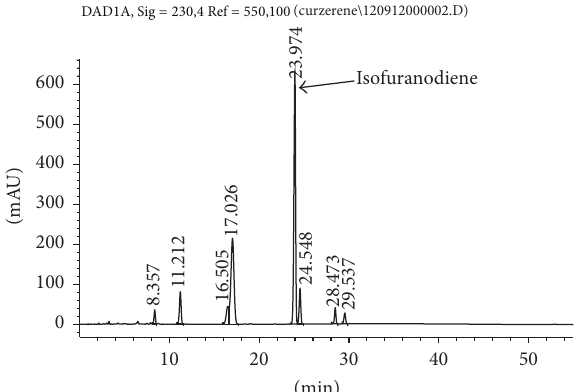
Figure 2: HPLC chromatogram of the essential oil from flowers of Smyrnium olusatrum . Isofuranodiene with a retention time of 23.974 ministhemainpeak(48%).Thechromatographicconditions are as follows: column: Kinetex PFP 100A ( 100 × 4.6 mm i.d., 2.6 𝜇 m) from Phenomenex (Torrance, CA); mobile phases: water (A)-acetonitrile(B)(0–15min:40%B;15–30min:60%B;30–40 min 60% B)withaconstantflowrateof1 mL/min;injectionvolume:1 𝜇 L;